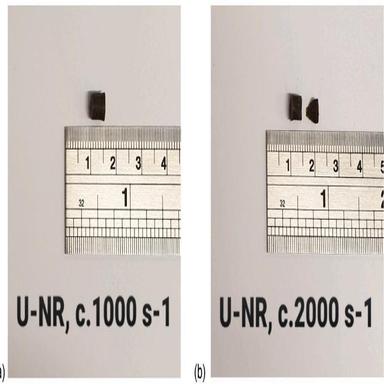
Post-mortem examination for high strain rate experiments at − 60 ◦C for U-NR at (a) c. 1000 s − 1 and (b) c. 2000 s − 1 .